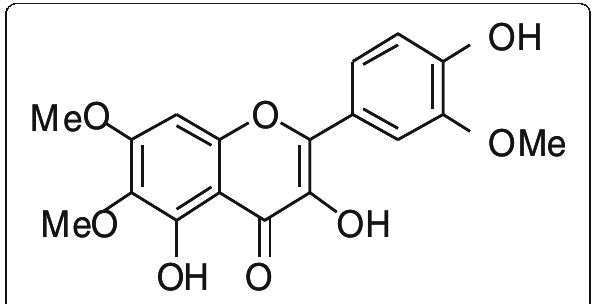
Fig. 1 Chemical structure of 3,5,4 ′ -trihydroxy-6,7,3 ′ -trimethoxyflavone